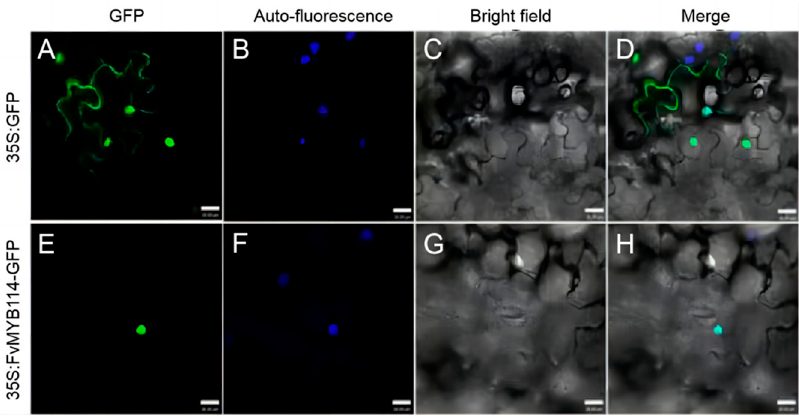
Figure 3. Subcellular localization of FvMYB114. The 35S:GFP and 35S:FvMYB114 plasmids were transformed into the cells by particle bombardment. ( A , E ) GFP fluorescence; ( B , F ) Auto-fluores- cence ; ( C , G ) Bright-field images; ( D , H ) Merged. Bar = 50 μ